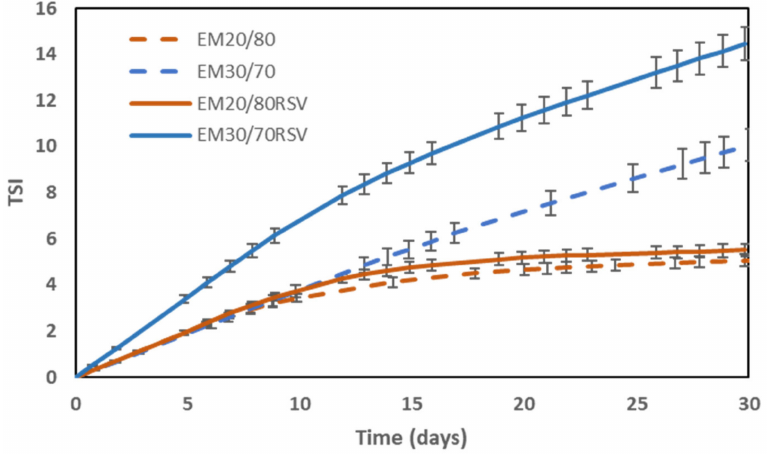
Figure 2. Evolution of the Turbiscan Stability Index (TSI) of the different types of emulsions over time to study how the addition of RSV to emulsion affects stability.